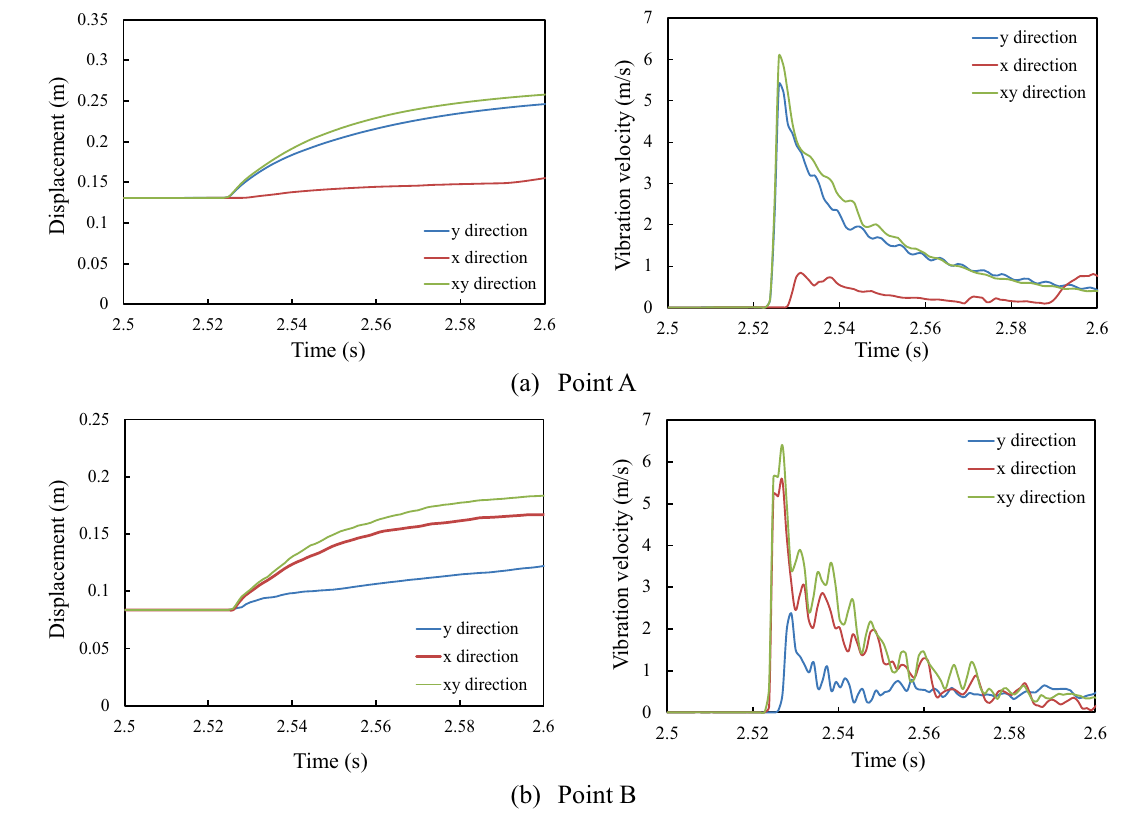
Fig. 20 Displacement and vibration velocity–time evolution curves for two monitoring points around circular cavern with a nearby struc- tural plane when subjected to external dynamic disturbances. Note: